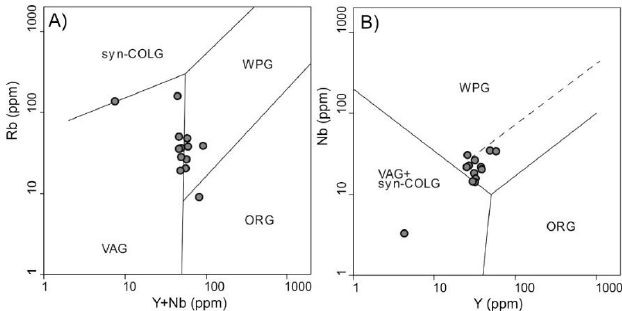
Figure 10. ( A , B ) Discrimination diagrams from [45]. IIC rocks plot close to the boundary between volcanic arc granites (VAG) and within-plate granites (WPG). ORG: oceanic ridge granites; syn-COLG: collision